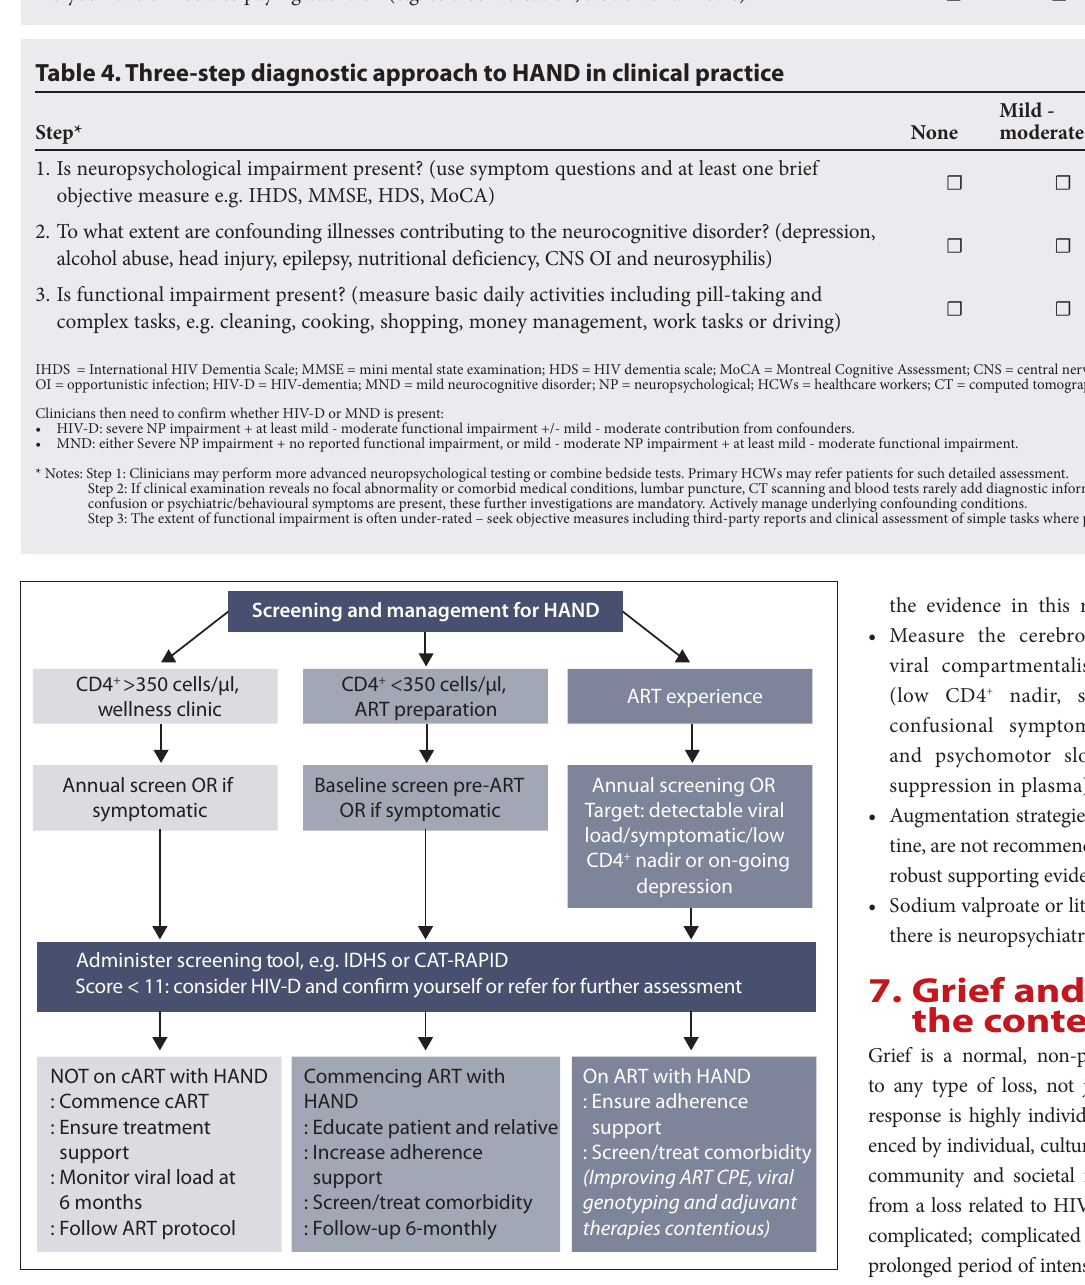
Fig. 5. Screening and management of HANDs. (CPE = CNS penetration